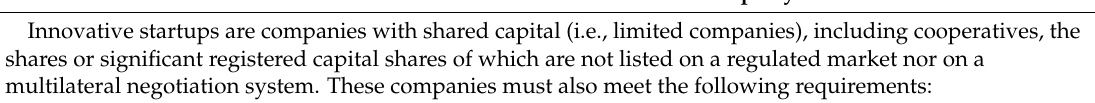
Table A1. Italy’s startup Act.